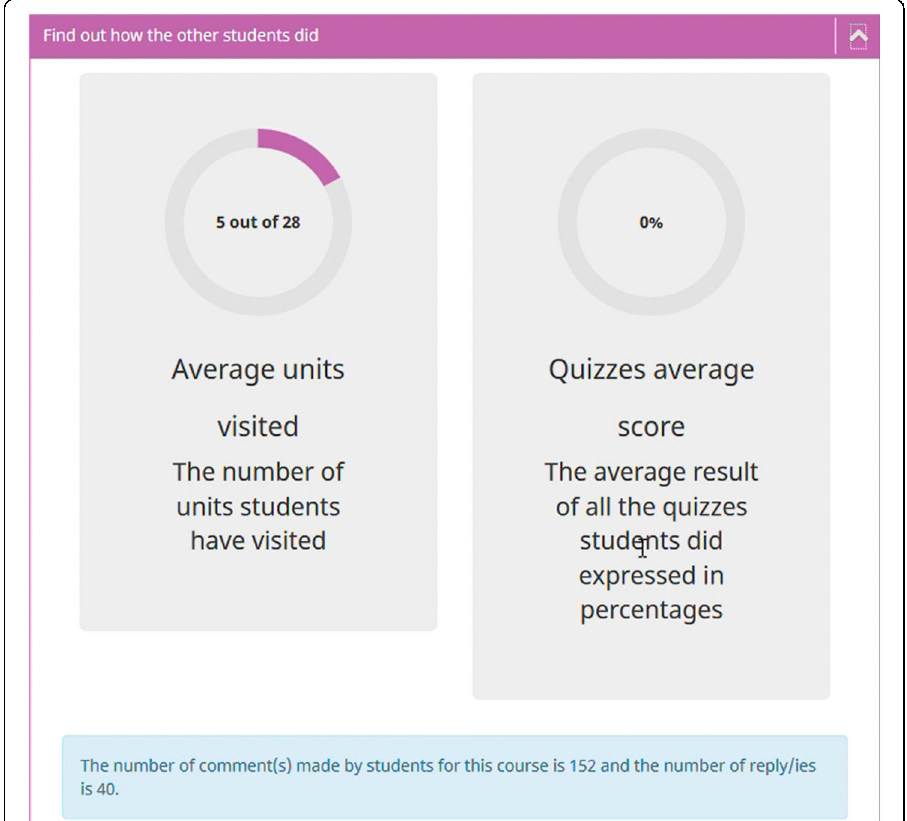
Fig. 19 Ring charts with aggregate statistics and bar on comments and